Question: Summarize what this figure shows in one sentence.
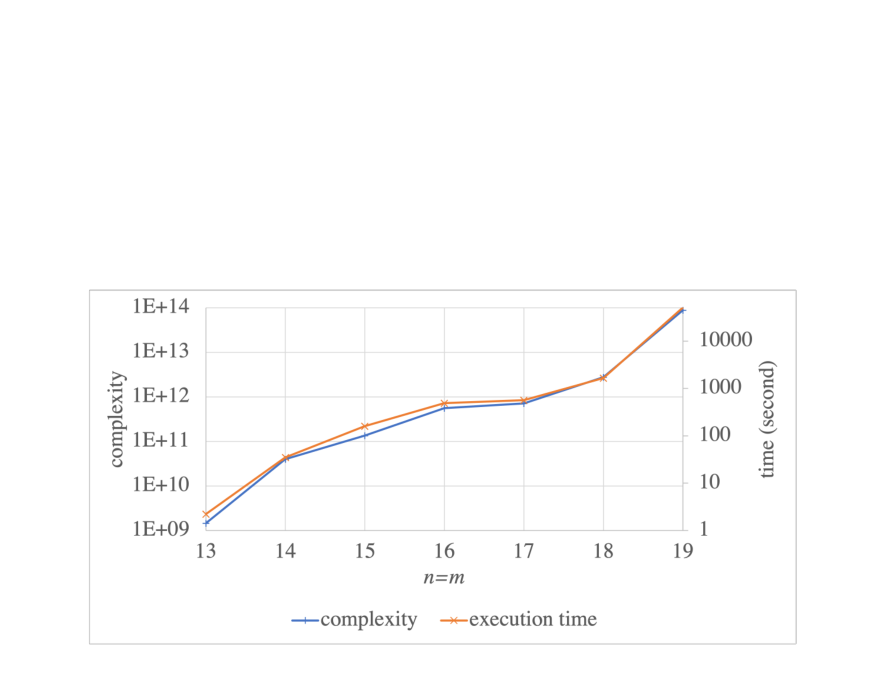
Answer: Comparison between the estimation of complexity by (4.7) and the execution time of the Linearize(1) step on an MQ system with n = m over F24.